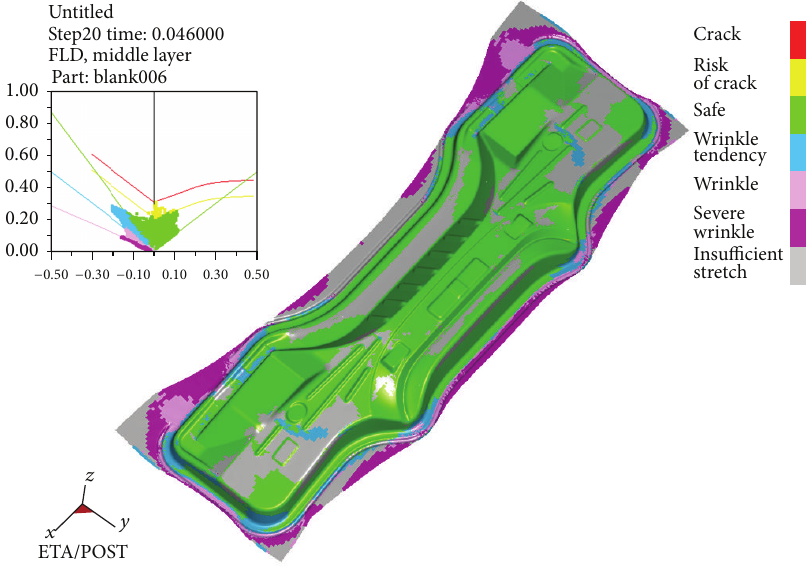
Figure 7: Forming limit diagram of the forming parts for A1B3C3D1 optimized